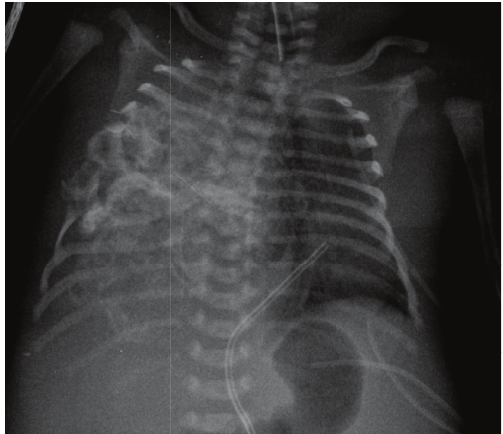
Figure 2: Chest X-ray showed right hemithorax opacification due to a large-sized mass with calcium density and destruction/erosion of the 4th–7th right costal arches, plus leftward tracheal deviation and centralized intestinal